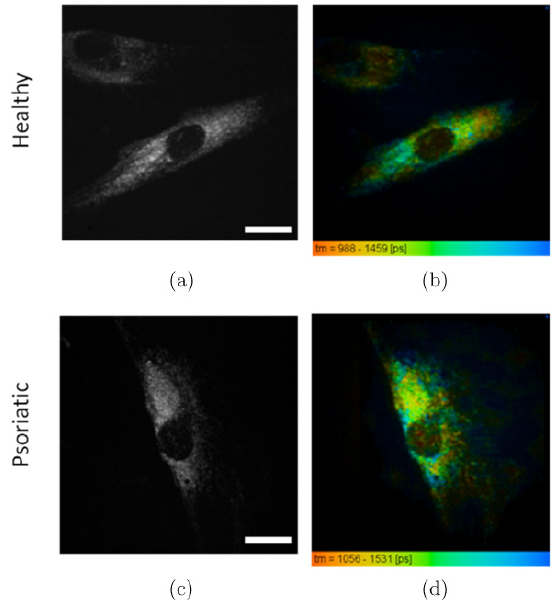
Fig. 4. (a) Healthy ¯broblast °uorescence intensity image, (b) °uorescence lifetime color coded image; (c) Psoriatic ¯broblast °uorescence intensity image, (d) °uorescence lifetime color coded image (scale bar ¼ 20 (cid:1) m). 25 (Permission has been granted by \SPIE".)